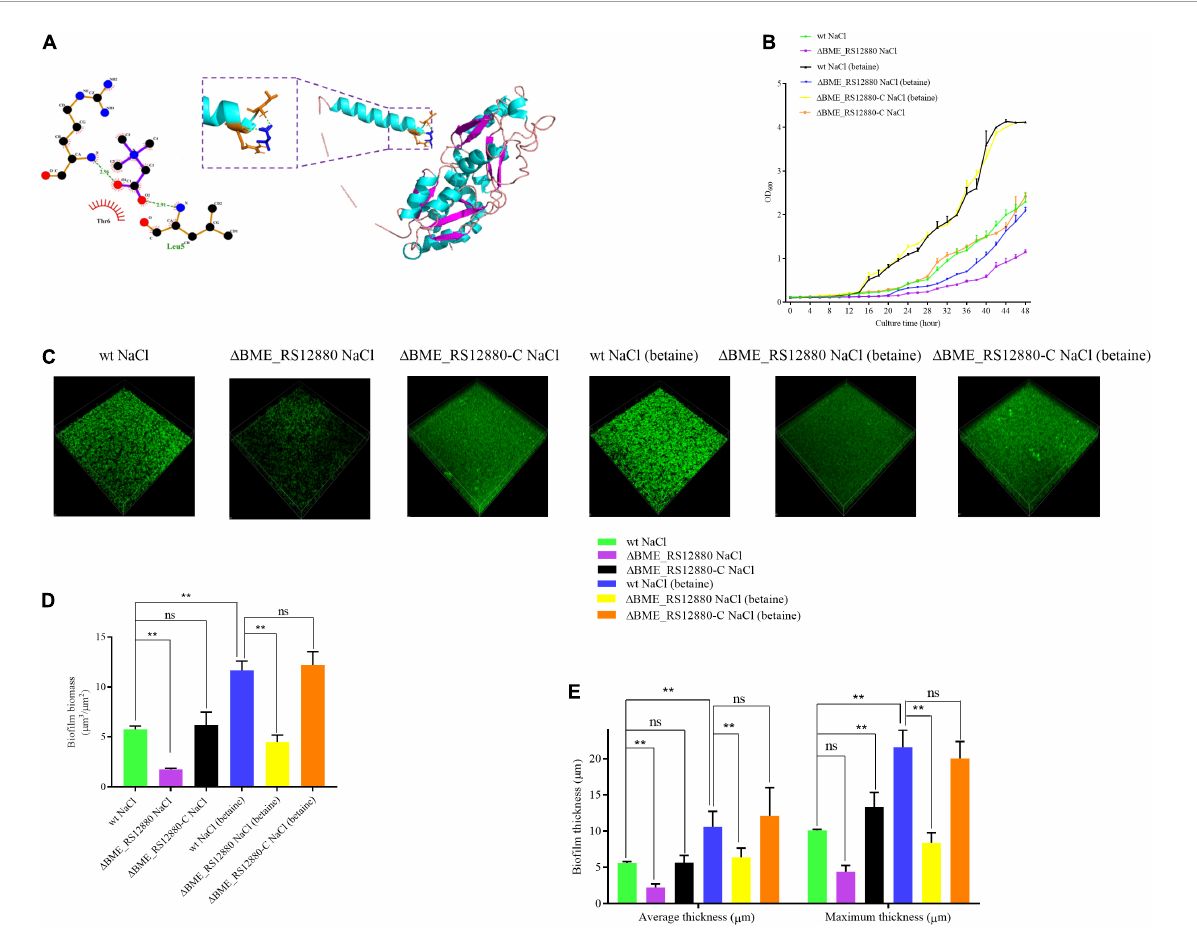
FIGURE6 Functional analysis of (cid:49) BME_RS12880 in response to osmotic stress. (A) Molecular model of BME_RS12880 binding to betaine. The light blue cartoon structure indicates the BME_RS12880, the navy blue structure indicates betaine, the structure consisting of light blue and brown represents the residues bound to betaine, and the green dashed lines indicate hydrogen bonds. (B) Growth of the wt, (cid:49) BME_RS12880, and (cid:49) BME_RS12880-C strain in Brucella broth under osmotic or supplemented with 1 mM betaine. Error bars represent the standard deviations of three independent experiments. (C) Live confocal imaging of stacks of (cid:49) BME_RS12880 and (cid:49) BME_RS12880-C strain biofilms grown for 20 days in Brucella broth medium under osmotic or supplemented with 1 mM betaine. Scale bars = 20 µ m. Confocal images were subjected to quantitative analysis using the Comstat2 program to determine the biofilm biomass (D) and the average and maximum biofilm thickness (E) . All experiments were carried out at least in triplicate. Error bars represent standard error ( n ≥ 3). One-way ANOVA was used followed by Dunnett’s test to assess significance. ** P ≤